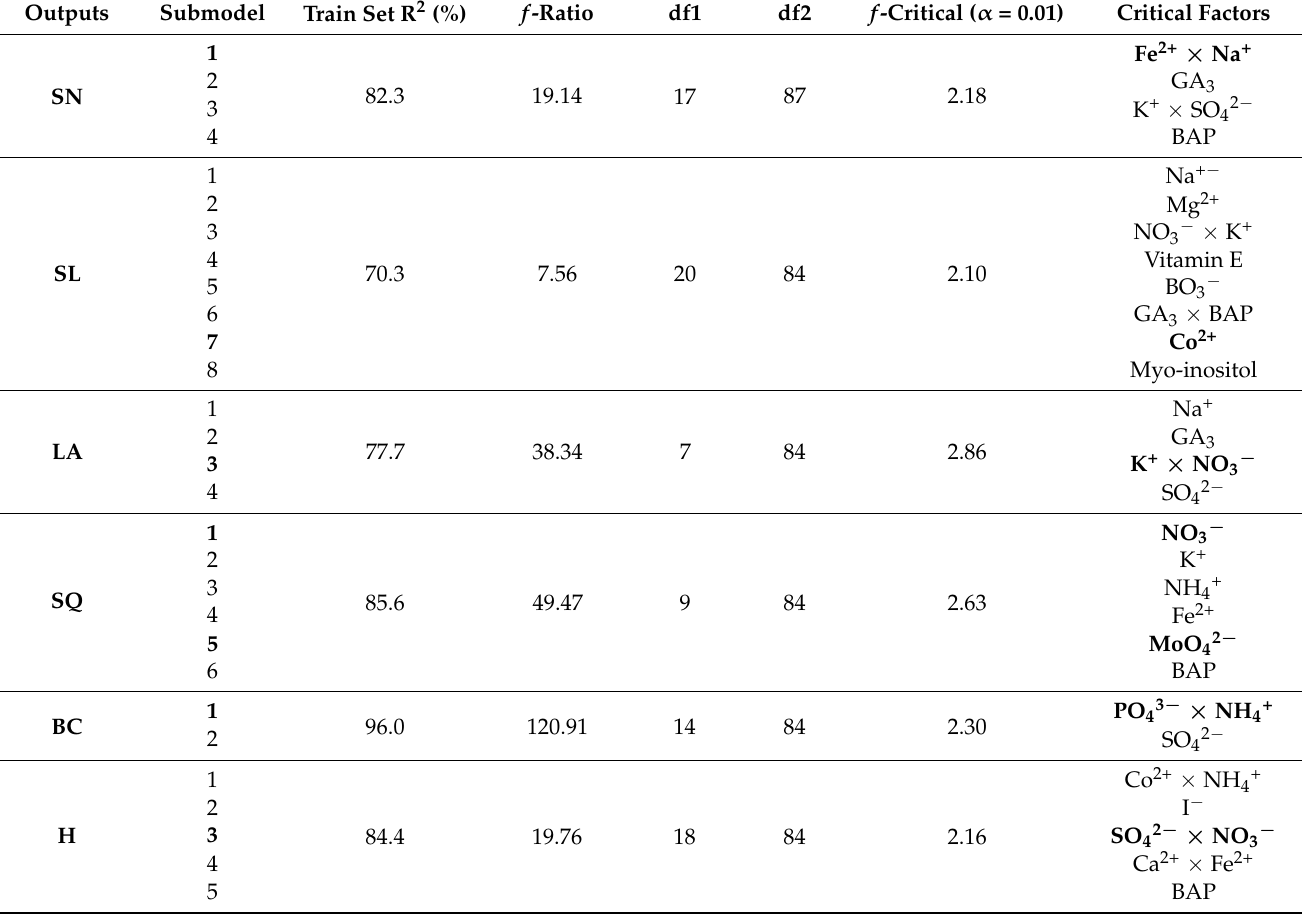
Table 1. Neurofuzzy logic model train set R 2 , ANOVA parameters for training ( f -ratio, degrees of freedom (df1: model and df2: total), f -critical value for α = 0.01), and critical factors (inputs selected by the model) for each output (SN: shoot number, SL: shoot length, LA: leaf area, SQ: shoot quality, BC: basal callus, H: hyperhydricity). The inputs with a stronger effect on each output